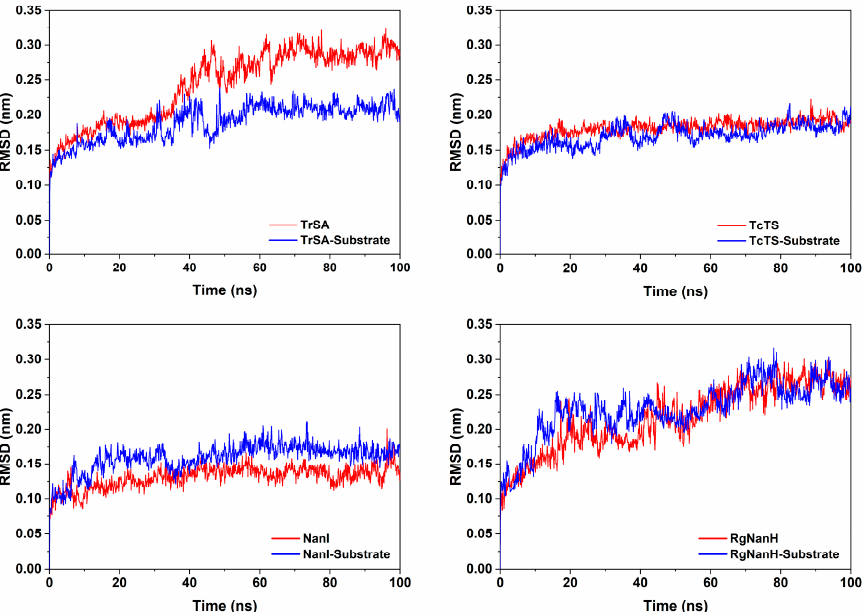
Figure 1. Time evolution of the backbone RMSD for GH33 sialidases with and without the substrates. The calculated data of the substrate-free and substrate-bound states are shown in red and blue, respectively.